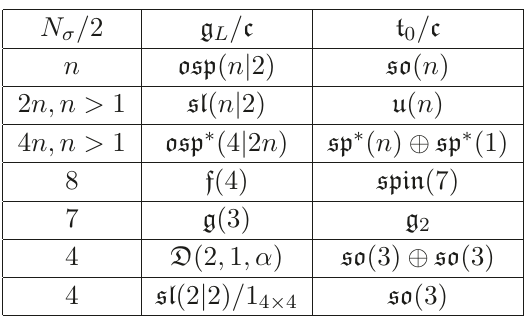
In all cases, ( g L / c ) 0 = so (1 , 2) ⊕ t 0 / c . It is required that N σ / 2 < 16 as there are no maximally supersymmetric AdS 3